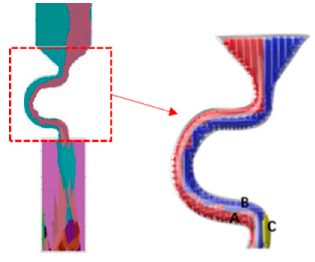
Figure 14. Simulation results in the selector parts of C 1 (d w = 3 mm, d s = 4 mm).